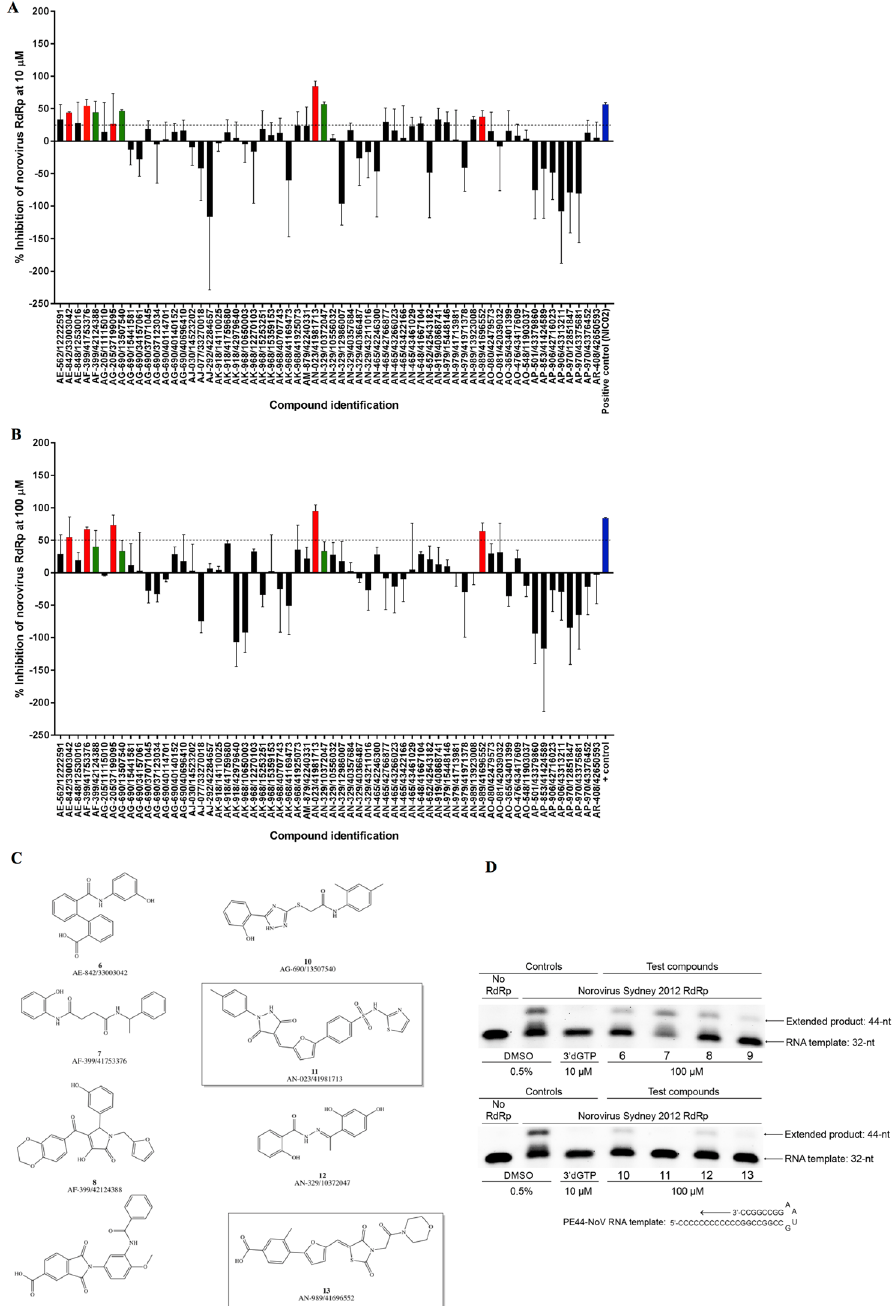
Figure 4. Initial screen for inhibition of human norovirus Sydney 2012 RdRp activity. The effects of 62 compounds were examined against norovirus RdRp activity using a fluorescent activity assay at 10 µ M ( A ) and 100 µ M ( B ). Five compounds that exhibited more than 25% inhibition at 10 µ M and 50% inhibition at 100 µ M (red bars) and three soluble compounds that exhibited more than 25% inhibition at both concentrations (green bars) were chosen for further assessment with a counter-screen gel-shift RdRp assay. The positive control (blue bars) is a previously reported norovirus NNI RdRp inhibitor NIC02 (10 µ M in ( A ) and 100 µ M in ( B ) 14 . The mean values of triplicate datasets with standard deviation are shown. ( C ) Structure of the eight most potent compounds with 11 and 13 highlighted. ( D ) A counter-screen gel-shift assay was used to confirm norovirus RdRp inhibitory activity of hit compounds. The eight compounds were examined for inhibition of primed elongation activity. PE44-NoV RNA templates (32 nucleotides) were extended (44 nucleotides) by the RdRp in the absence of any test compounds (0.5% DMSO [vol/vol] negative control) or with test compounds at a fixed concentration of 100 µ M. The nucleoside analogue 3 ′ -deoxyguanosine-5 ′ -triphosphate is used as a positive control (10 µ M) to demonstrate complete inhibition, and no RdRp was used as a negative control. Full-length gels are presented in Supplementary Fig.